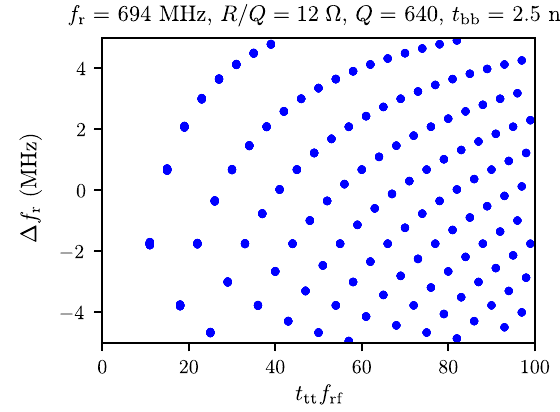
FIG. 17. Cases when the spectral line hits the HOM with frequency variation (cid:3) 5 MHz. Calculations are done for the Z machine parameters using Eq. (18).